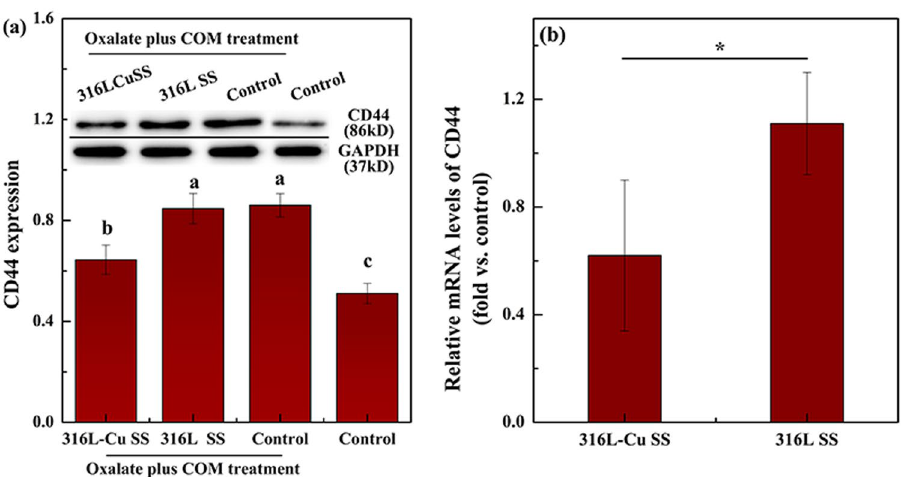
Figure 5. 316L-Cu SS attenuates the expression of CD44. ( a ) Western blot analysis and ( b ) relative mRNA expression gene transcription of CD44. A significant difference at p < 0.05 is shown with different letters * p < 0.05. Intact western blot results can be seen in Supplementary